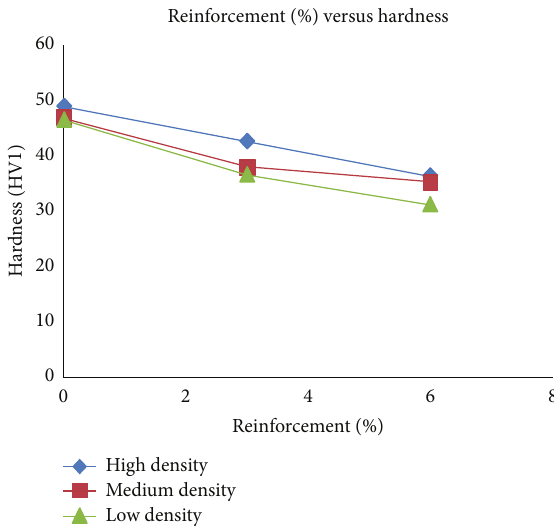
Figure 2: Variation of hardness of Al-Gr composites with varying graphite content.